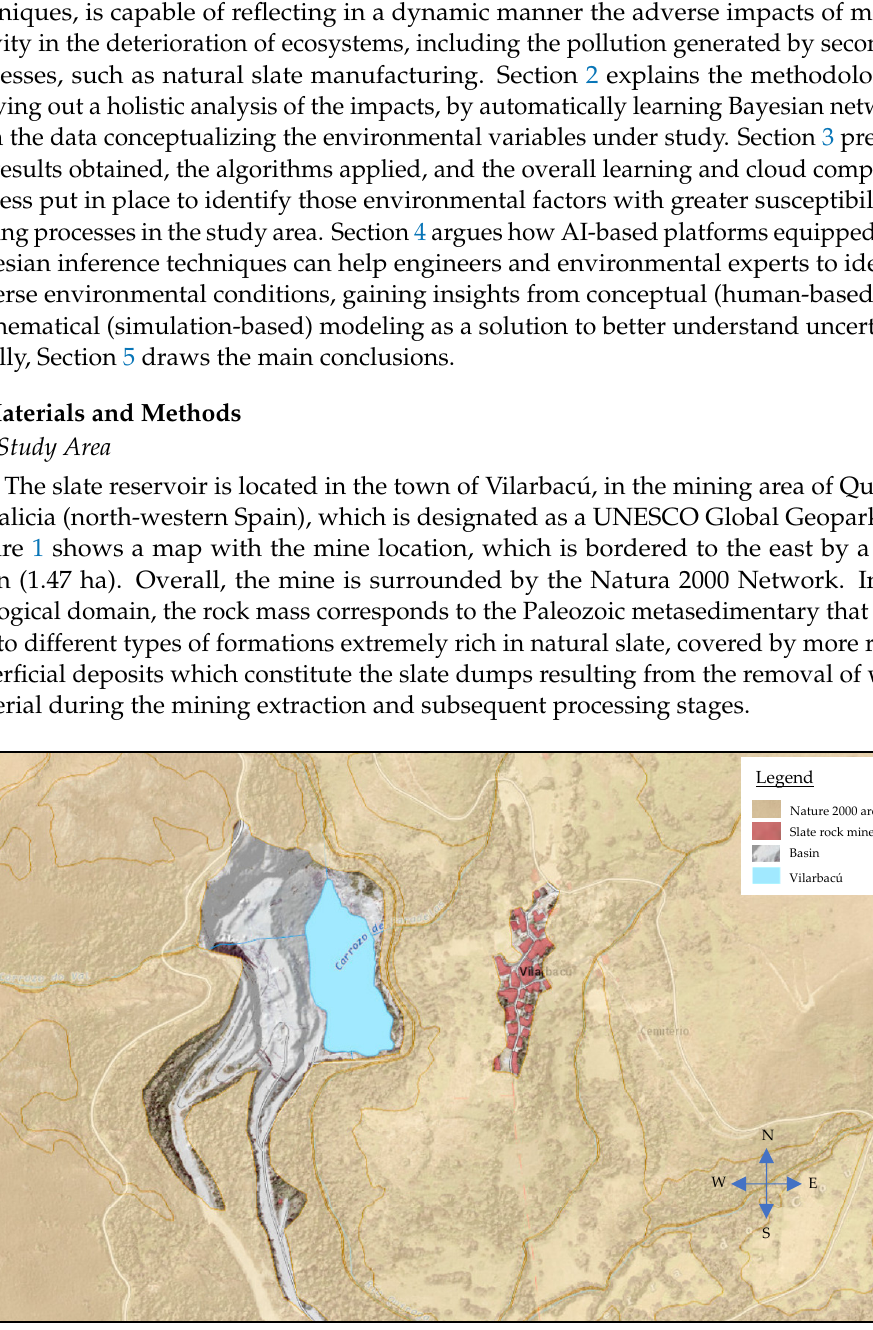
Figure 1. Map of the study area with the slate rock mine dominated by the Natura 2000 Network.